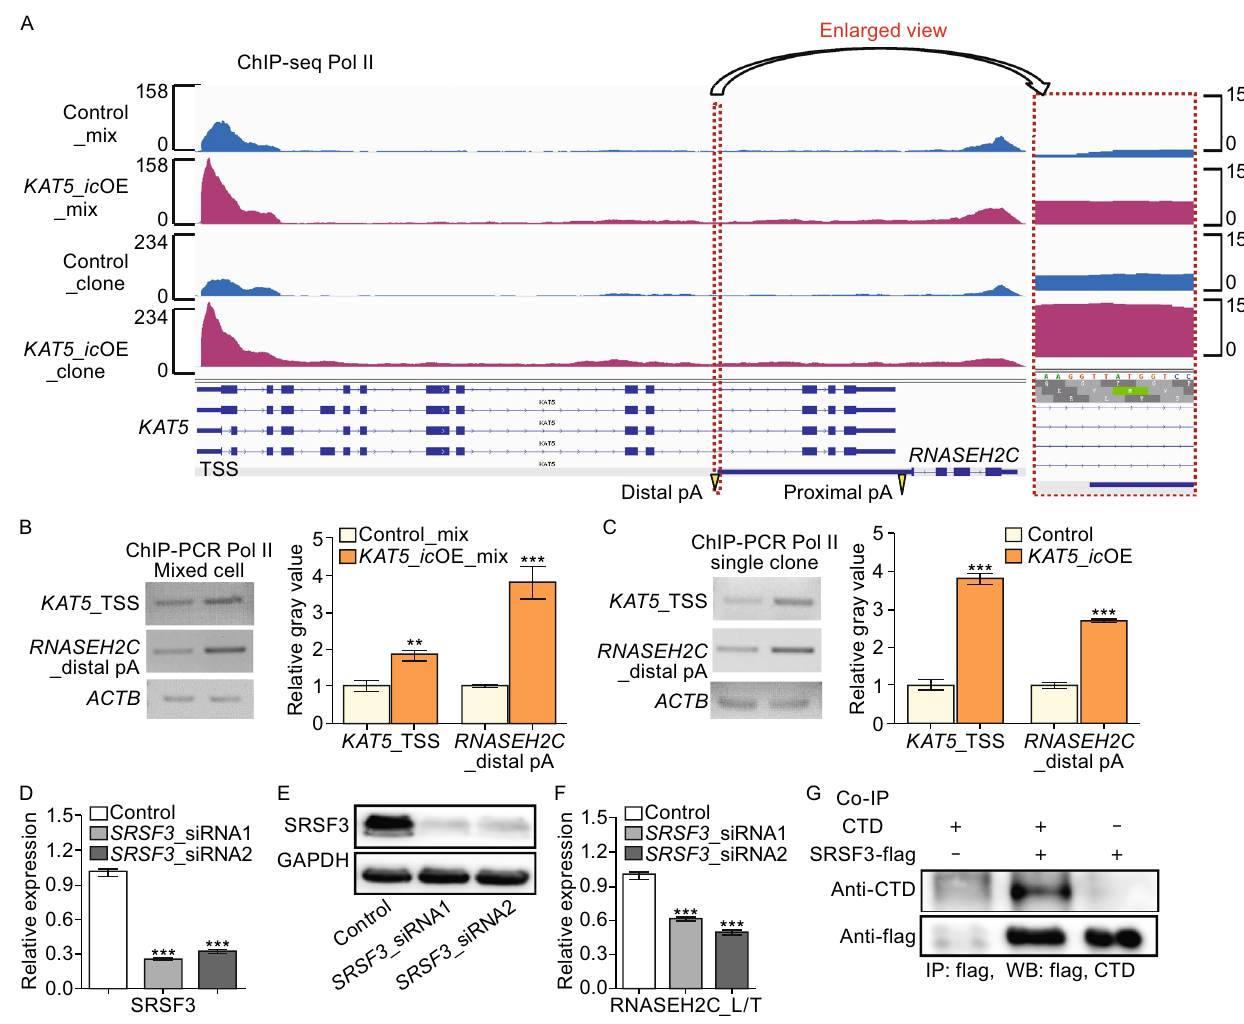
Figure 5. Higher Pol II occupancy and the recruitment of SRSF3 are associated with increased usage of distal pA site in